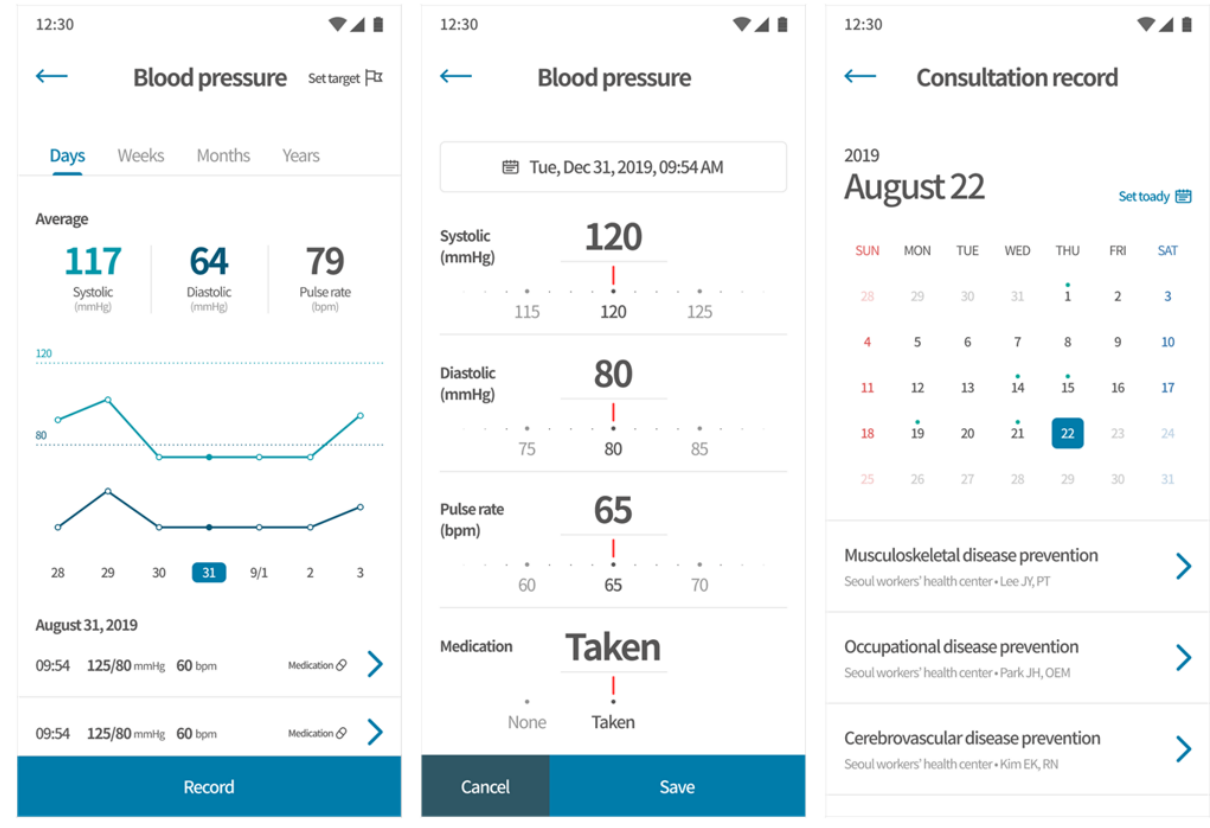
Figure 2. Personal health record